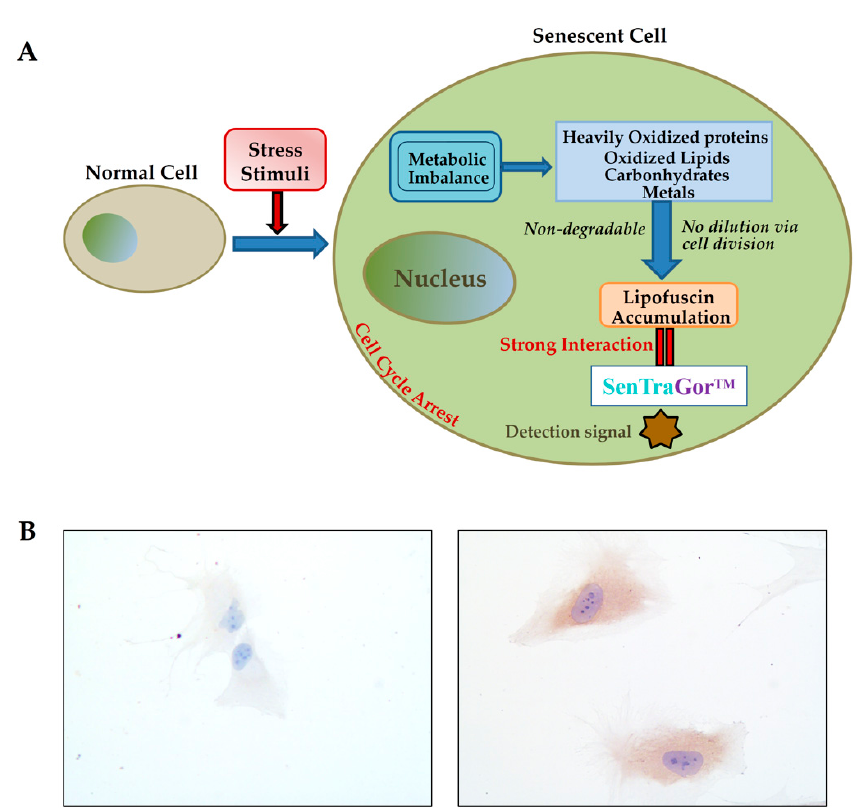
Figure 3. ( A ) SenTraGorTM specifically reacts against lipofuscin, the non-degradable byproduct of cellular senescence, allowing for the accurate identification of senescent cells in vitro and ex vivo by applying an antibody-mediated detection method. ( B ) SenTraGor staining on Li-Fraumeni-p21WAF1/Cip1 Tet-OFF (left image) and ON cells (right image); original magnification: ×200.